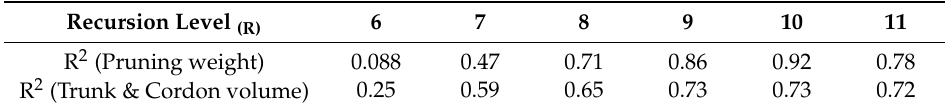
Table 1. This shows the R 2 of the linear correlation between the voxel number, pruning weight and trunk and cordon volume at increasing levels of octree voxelization (recursion level (R) ). Levels of recursion range from 6 to 11. The highest R 2 value for pruning weight was recursion level 10 and for trunk and cordon volume it was recursion levels 9 and 10.